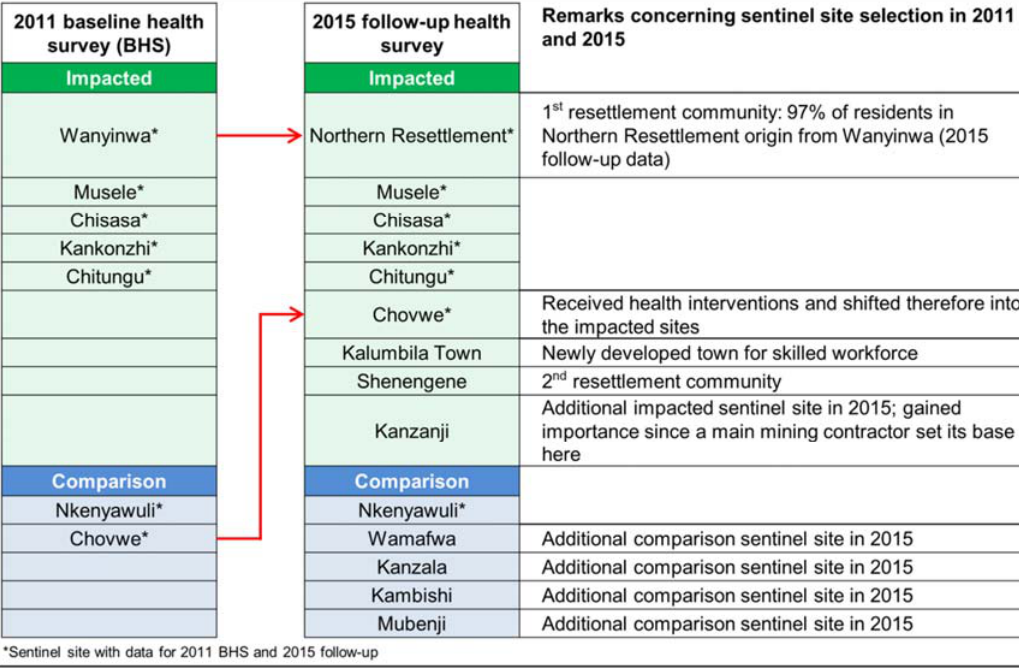
Figure 2. Sentinel site selection, Trident project, 2011 and 2015, Zambia.